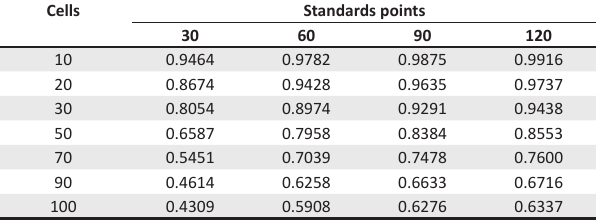
FIGURE 1 : Porter alignment index example calculation for 2 × 2 matrices. TABLE 3 : Sample mean alignment indices by number of cells and standard